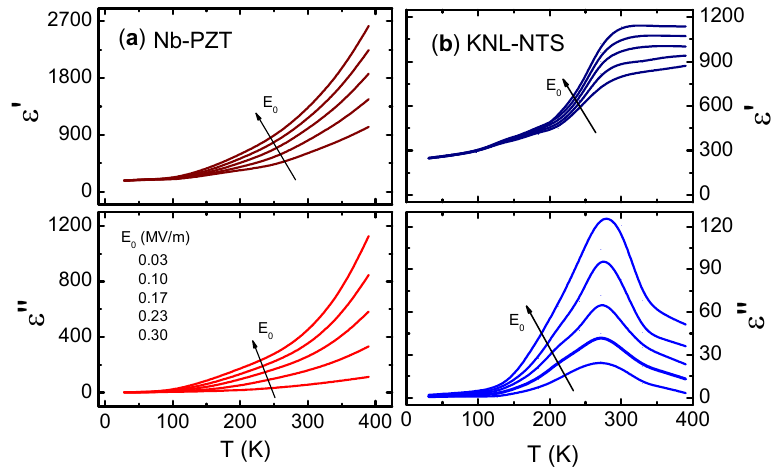
Figure 3. Temperature dependence of real, ε′ , and imaginary, ε″ , components of the relative dielectric permittivity at 1 kHz as a function of the amplitude of the applied electric field for ( a ) lead ‐ based Nb ‐ doped Pb(Zr 0.60 Ti 0.40 )O 3 (Nb ‐ PZT) and ( b ) lead ‐ free (K 0.44 Na 0.52 Li 0.04 )(Nb 0.86 Ta 0.10 Sb 0.06 )O 3 (KNL ‐ NTS). The data were partially extracted from the reference [38] (Copyright AIP Publishing LCC., 2012).